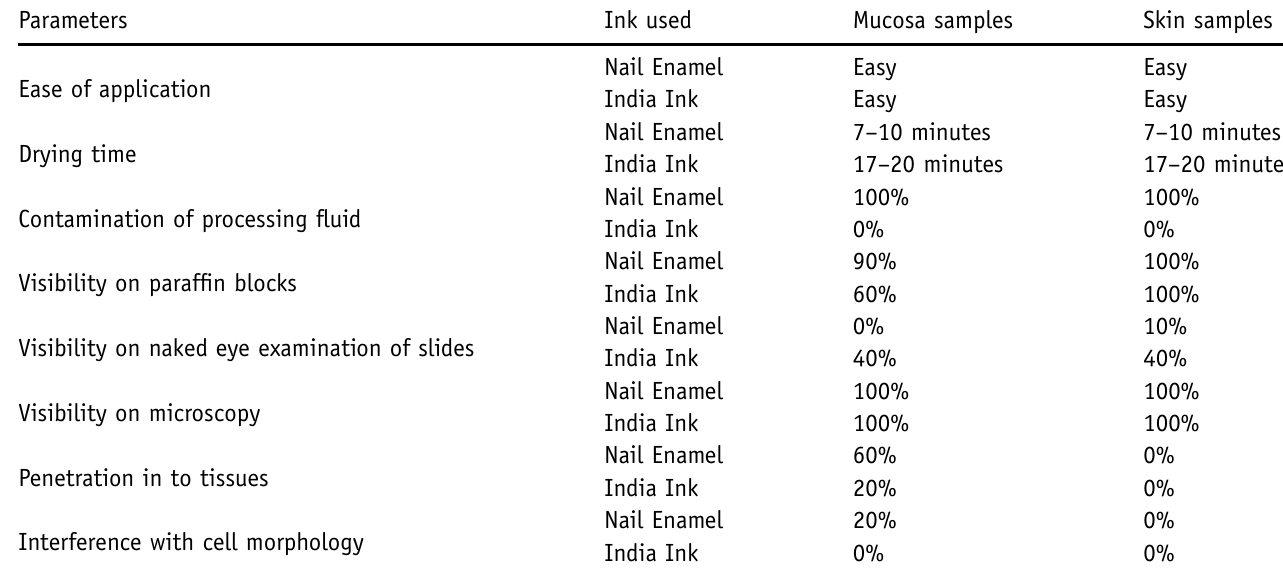
Table II. Macroscopic and microscopic parameters of Indian Ink and nail enamel on mucosal and skin margins. Parameters